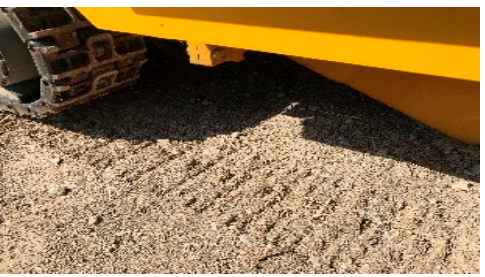
Figure 6. Experimental site of the turning motion on slope experiment.